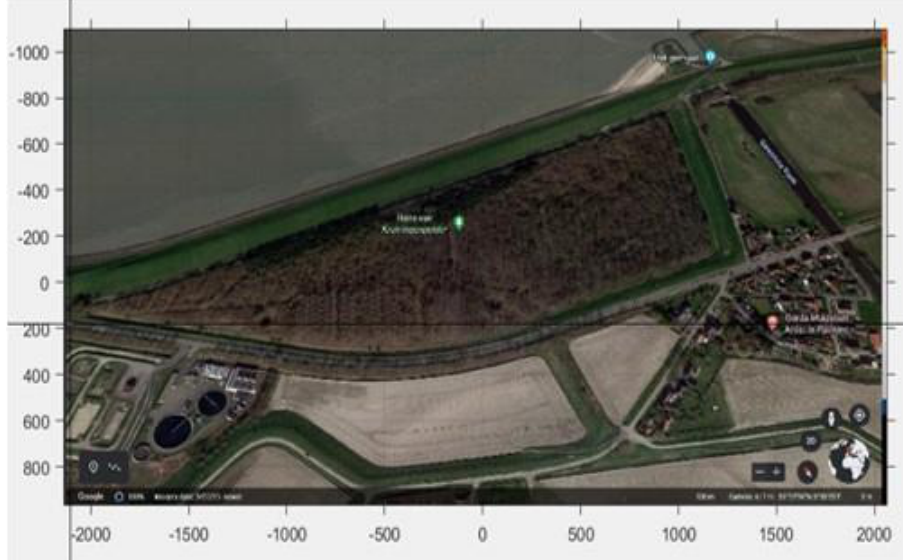
Figure 6. Processing Map Region for Grazing Field.